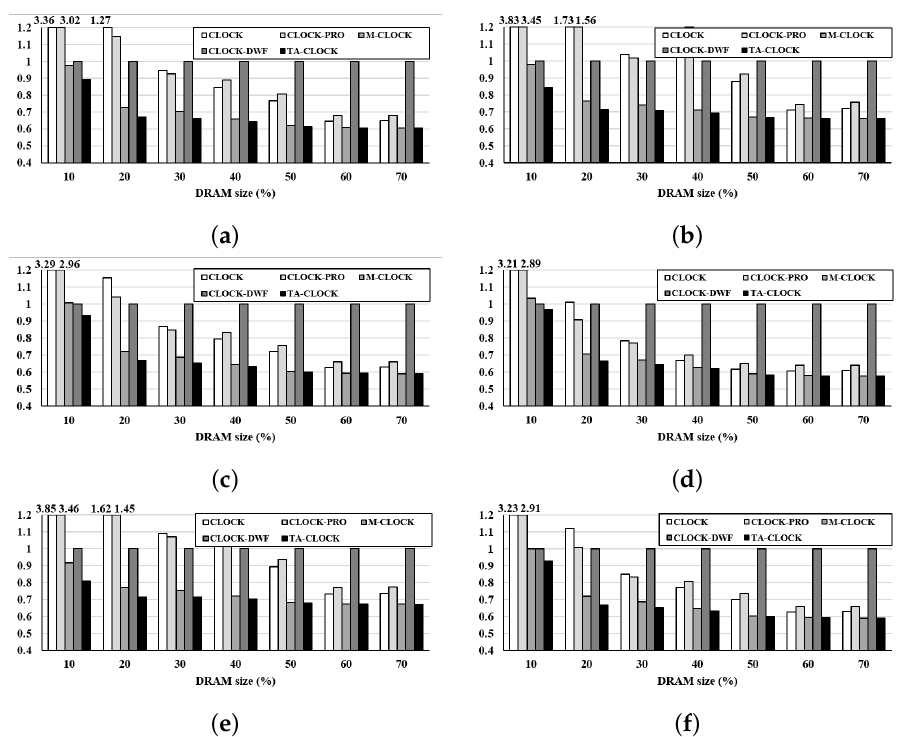
Figure 10. Normalized energy delay product (values of 1.2 or higher are indicated as 1.2). ( a ) basic- math; ( b ) blowfish; ( c ) dijkstra; ( d ) patricia; ( e ) qsort; ( f )